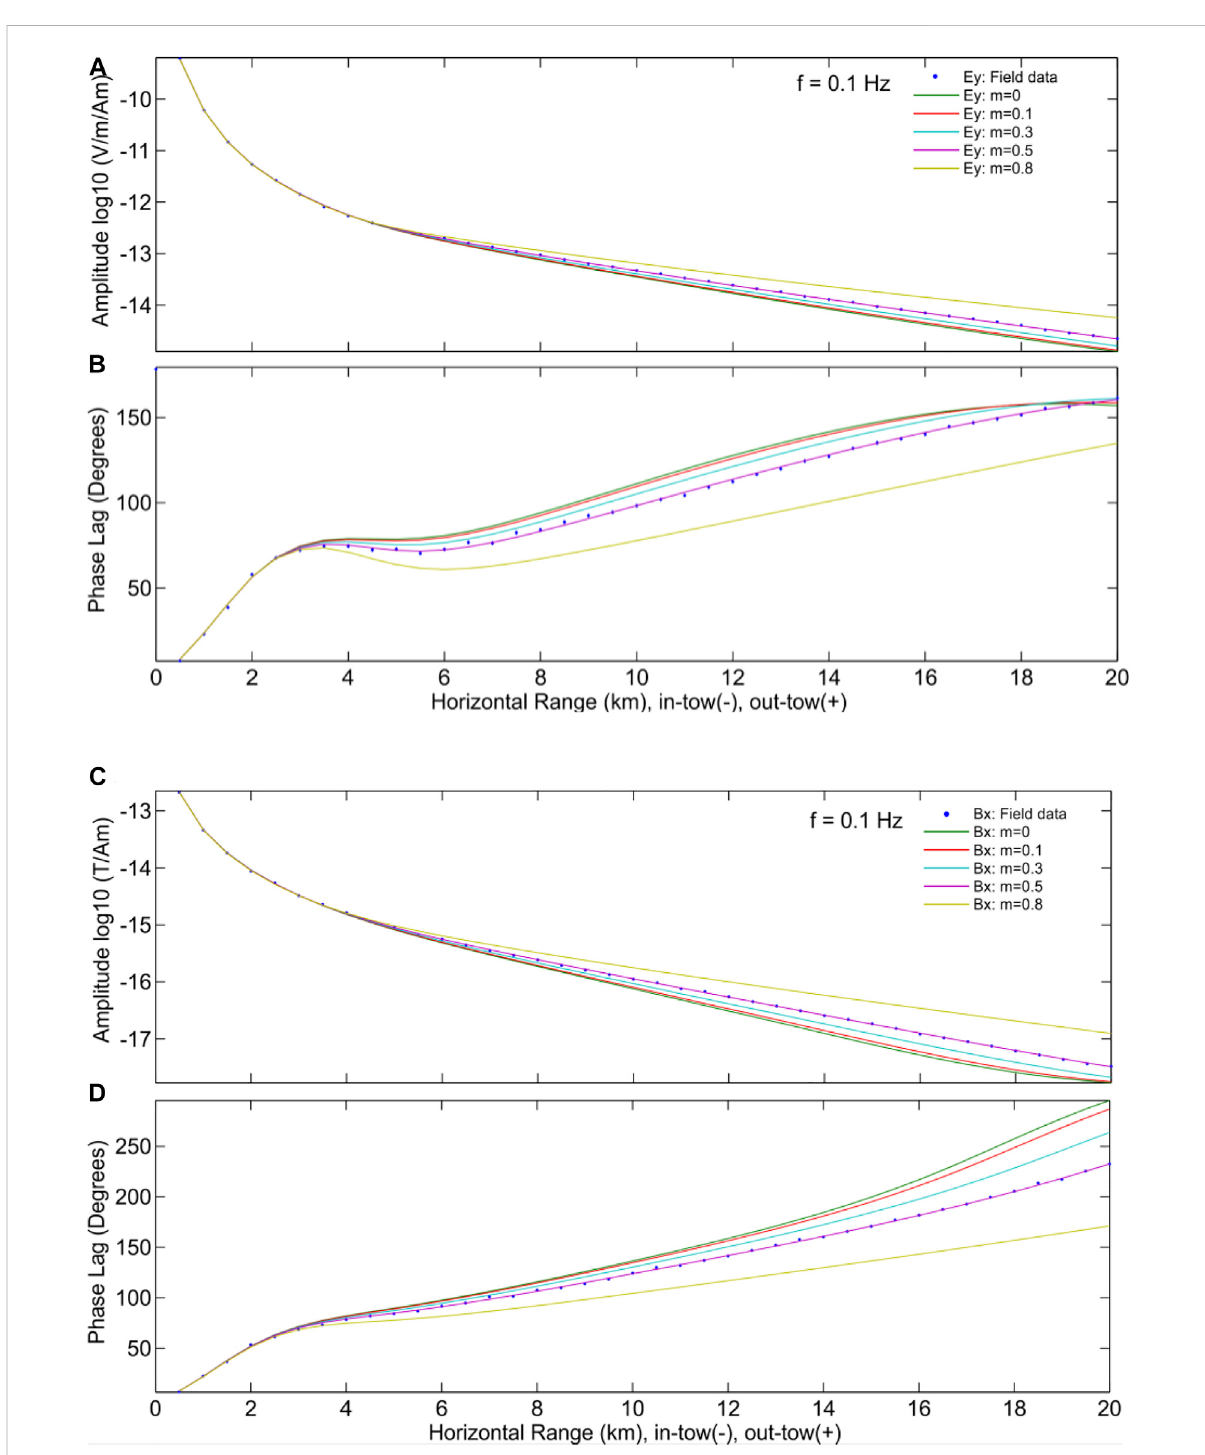
FIGURE 14 Log10 amplitude and phase (degrees) of f = 0.1 Hz CSEM fi eld data [Ey (A,B) and Bx (C,D) ]. Field data (blue) and inversion response with the Cole – Cole model of various polarizability m = 0 (pure electromagnetic fi eld) (green), 0.1 (red), 0.3 (light blue), 0.5 (purple), and 0.8 (yellow),